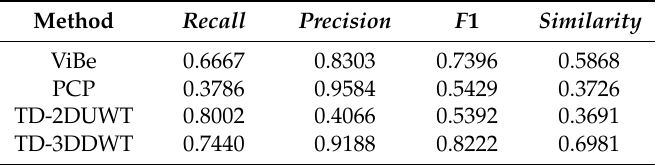
Table 14. Comparison of average metrics for the turnpike sequence.